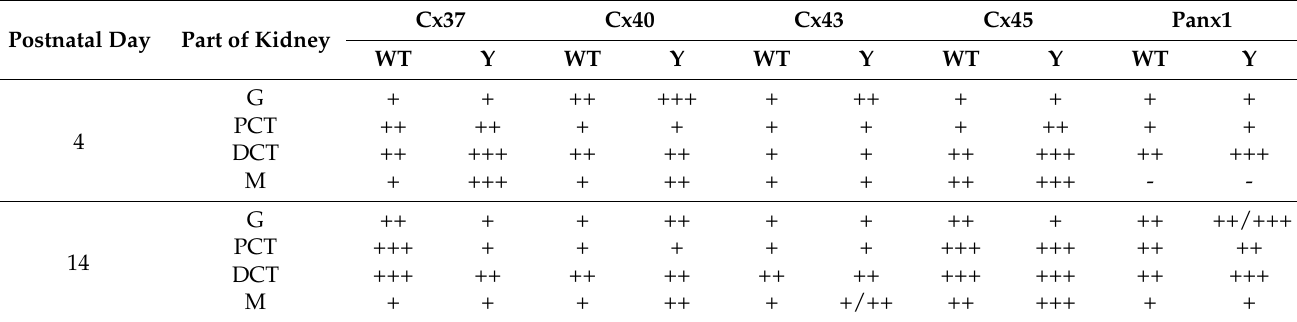
Table 1. Staining intensity to specific antibodies in control and yotari mouse kidneys during the 4th and 14th postnatal day. Postnatal